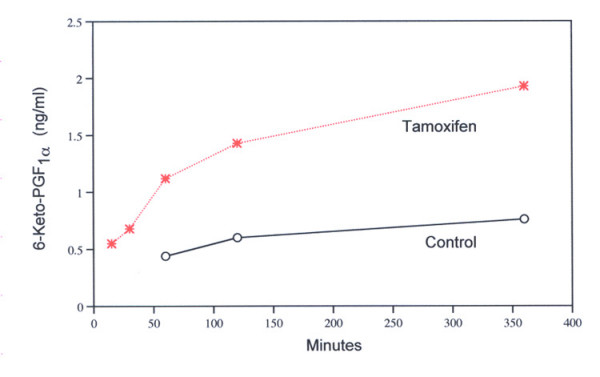
Time-course of 6-keto-PGF1α production by rat liver cells during incubation with 15 μM tamoxifen (γ) and MEM/BSA control (O). Analyses were performed with duplicate and triplicate dishes; mean values are shown.